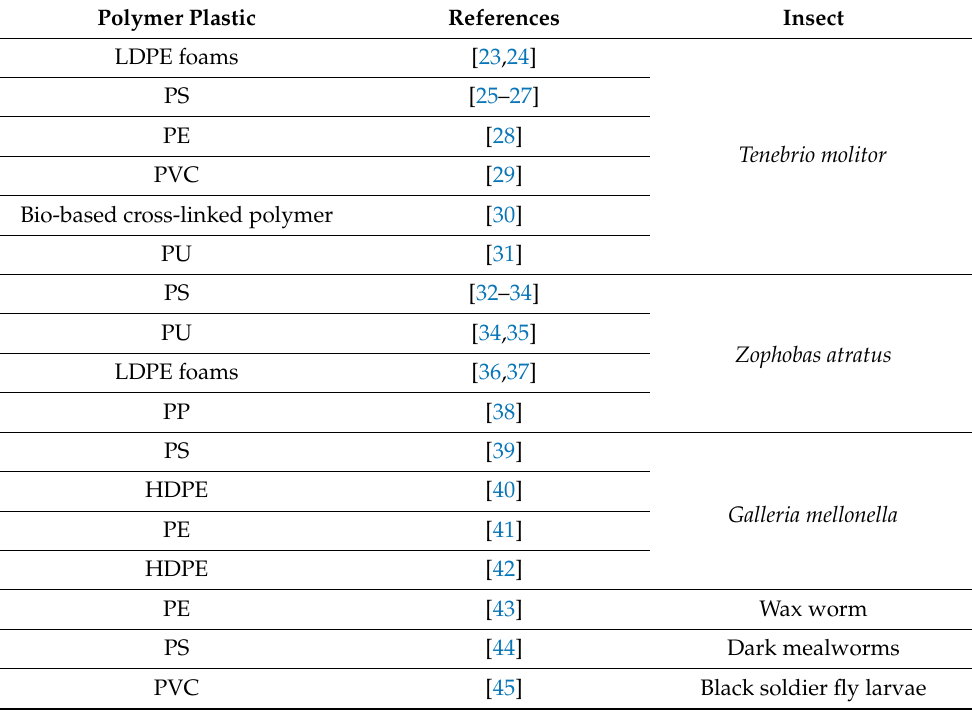
Table 1. The latest works on degradation of polymer plastics by